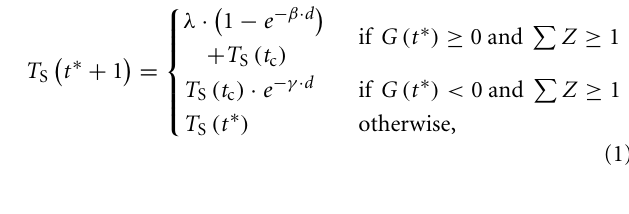
FIGURE 1 | Diagram of the computational model .Time units differ: t is in minutes and t * in hours. Output M ( t ) is the mood estimation within the allostatic framework which combines the rush/comedown effect of the drug, rc ( t ), with the virtual subject’s cognitive distortion, cd ( t ). Levels of observations include the neuropsychological scale in green, the cognitive scale in red, and the healing scale in orange (12), which are connected to the expanded PK/PD model (8) in light blue.The cognitive weights, which modulate the ongoing neural activity on the neuropsychological scale, define